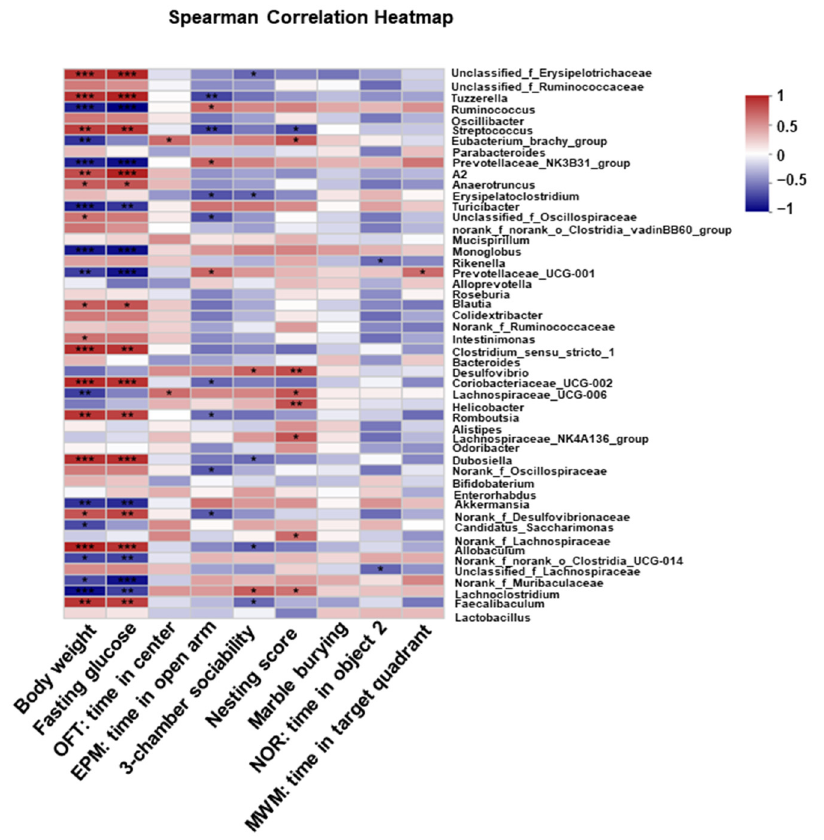
Figure 6. Effect of long-term HFD consumption on functions of gut microbiota in mice. Spearman correlation heatmap showing the correlations between neurobehavioral alterations and specific gut flora. * p < 0.05; ** p < 0.01; *** p < 0.001.